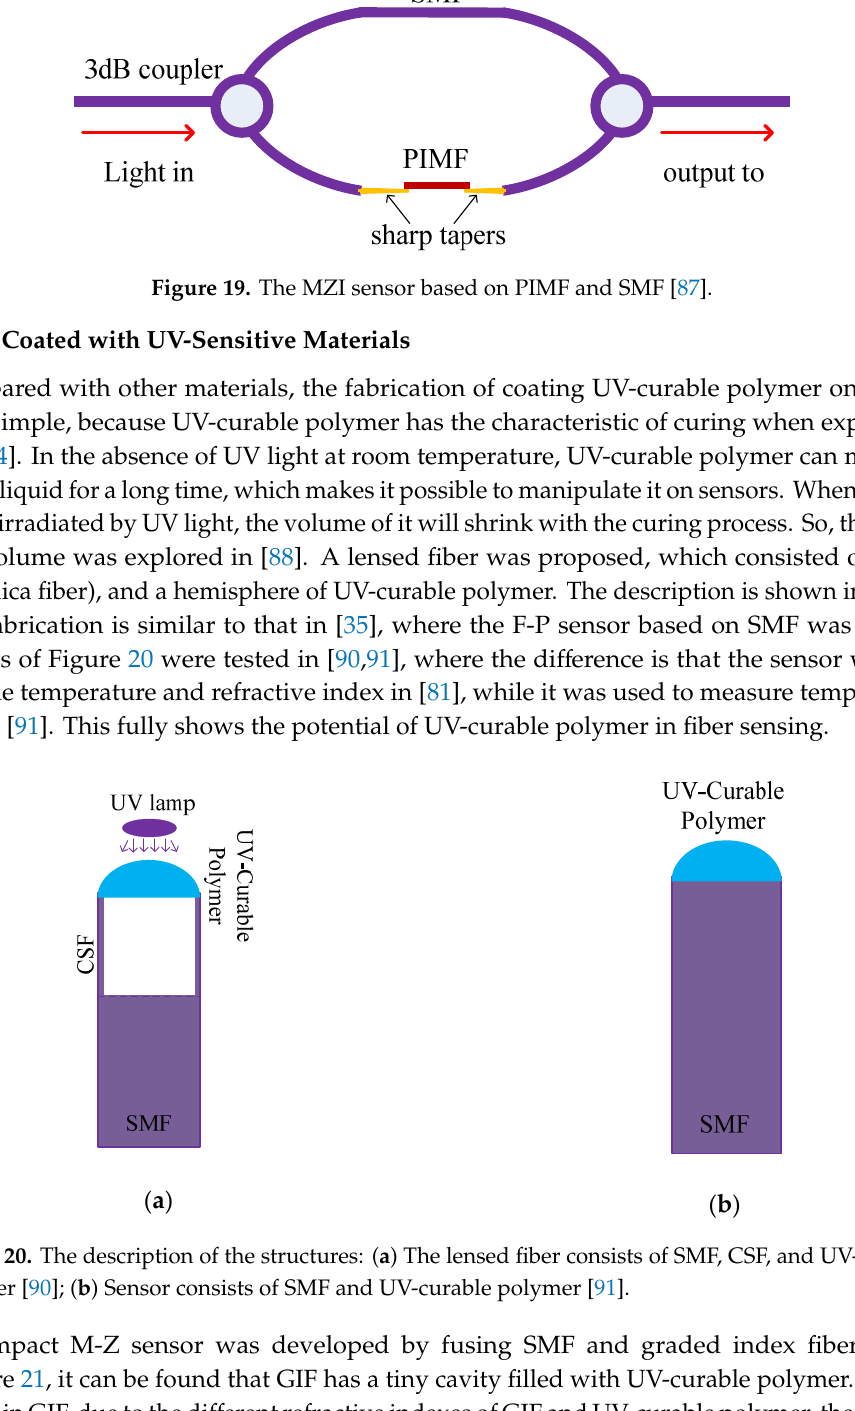
Figure 20. The description of the structures: ( a ) The lensed fiber consists of SMF, CSF, and UV-curable polymer [90]; ( b ) Sensor consists of SMF and UV-curable polymer [91].